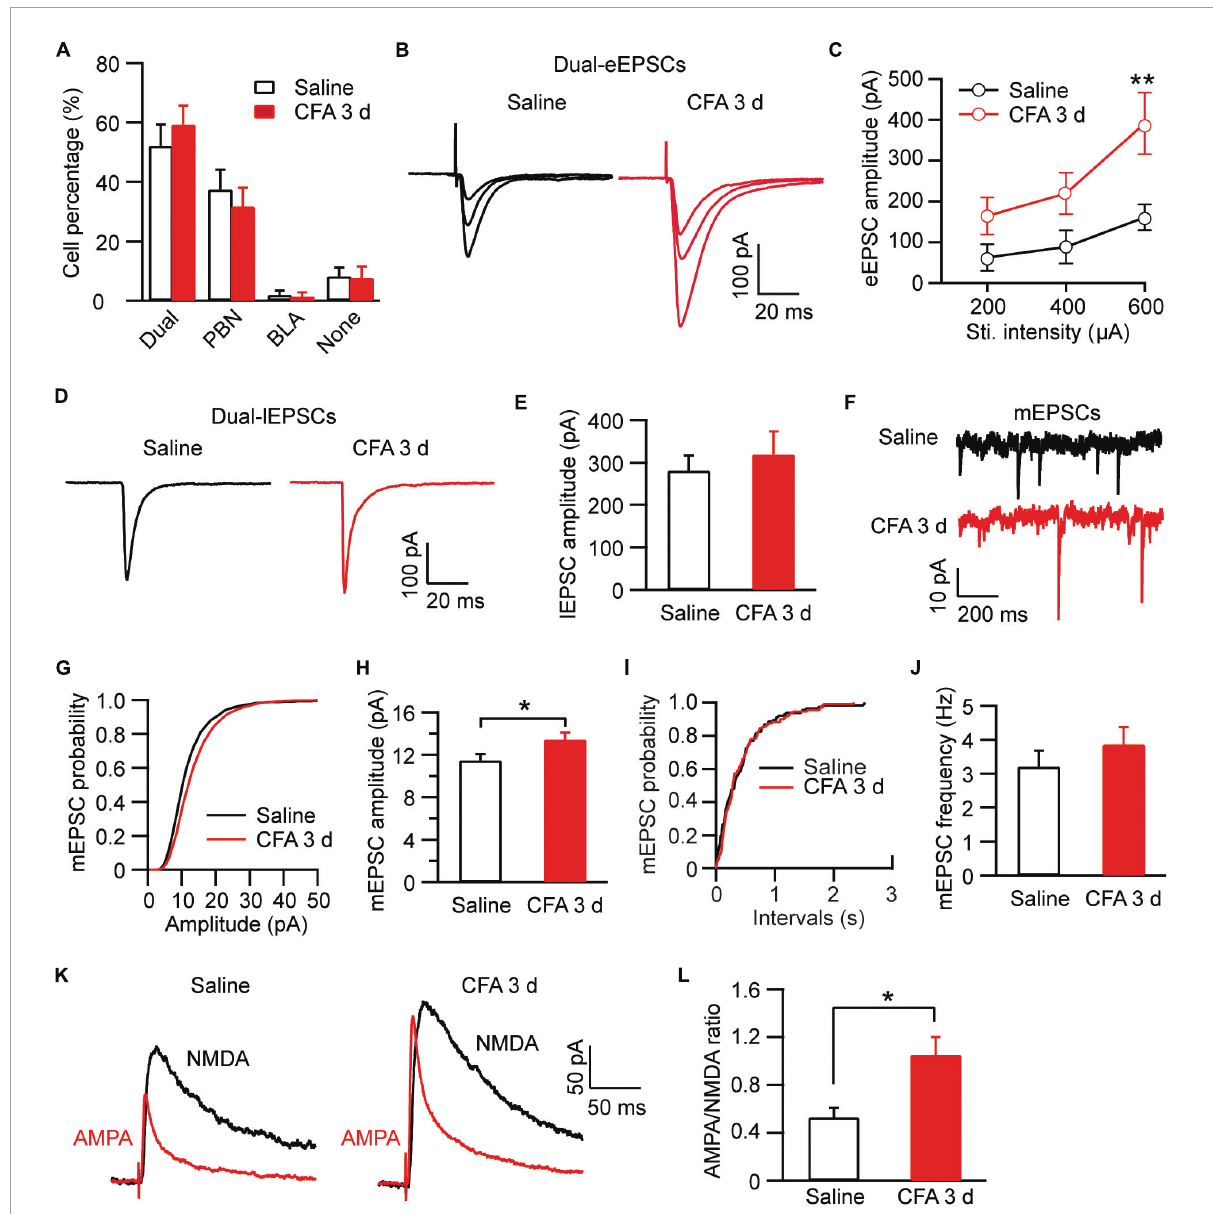
FIGURE6 Persistent pain activates BLA–CeAl inputs, not PBN–CeAl inputs in dual-input CeAl cells. (A) Group data of cell percentages for dual-input cells, PBN-input-only cells, BLA-input-only cells and none-input cells in CeAl from rats injected with saline or CFA. (B,C) BLA-elicited eEPSC traces (B) and group data of the eEPSC amplitude (C) in the dual-input CeAl cells from the saline- and CFA-injected rats. (D,E) PBN-elicited lEPSC traces (D) and group data of the lEPSC amplitude (E) in the dual-input CeAl cells from the saline- and CFA-injected rats. (F–J) mEPSC traces (F) and group data of mEPSC amplitude (G,H) and mEPSC frequency (I,J) in the dual-input CeAl cells from the saline and CFA rat groups. (K,L) Representative current traces of AMPA EPSCs and NMDA EPSCs (K) , and group data of AMPA/NMDA ratio (L) in the saline and CFA groups. * p < 0.05 and ** p <